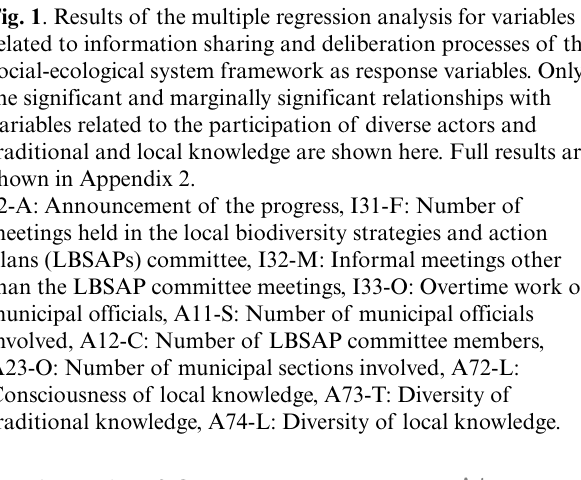
Fig. 1 . Results of the multiple regression analysis for variables related to information sharing and deliberation processes of the social-ecological system framework as response variables. Only the significant and marginally significant relationships with variables related to the participation of diverse actors and traditional and local knowledge are shown here. Full results are shown in Appendix 2.